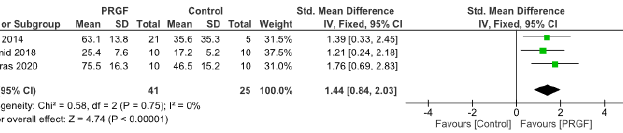
Figure 3. Meta-analysis of the studies evaluating new bone formation. SE: standard error; SMD: standardized mean difference; CI: confidence interval.